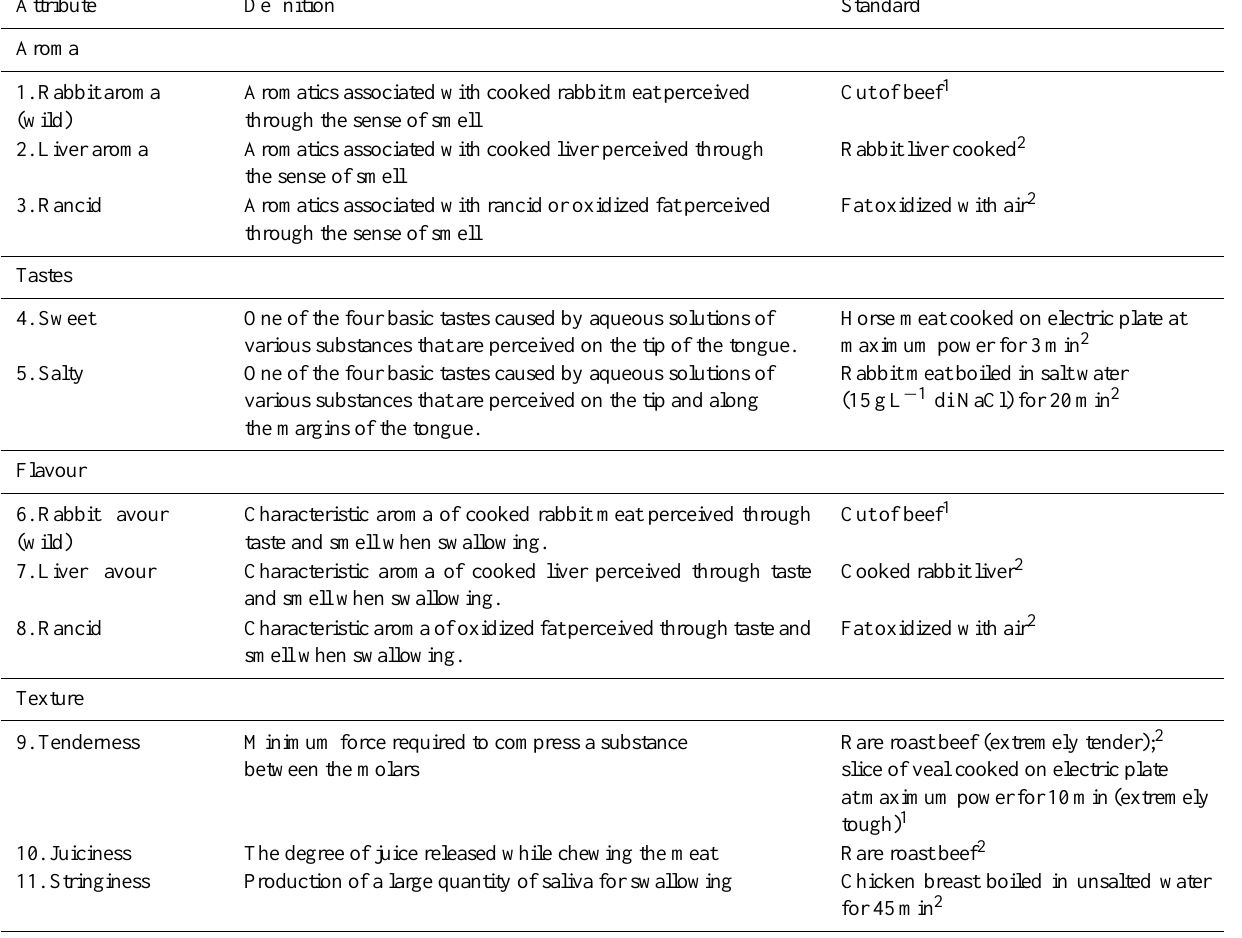
Table 1. Descriptors, definition and standards used in sensory